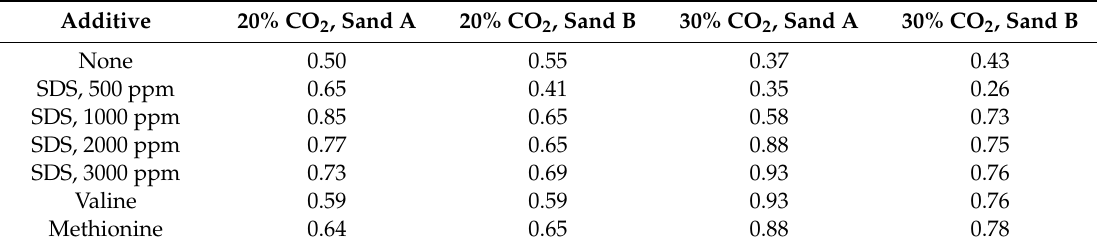
Figure 11. Concentration of feed gas (Gas A and Gas B) in the presence of di ff erent SDS and hydrophobic amino acids from Table 3. Table 4. Details of CO 2 split fraction calculated in the presence of amino acids and SDS for given sands (Sand A and Sand B) and given CO 2 concentrations (20% and 30%) in the incoming feed gas. Selected amino acids are of 3000 ppm